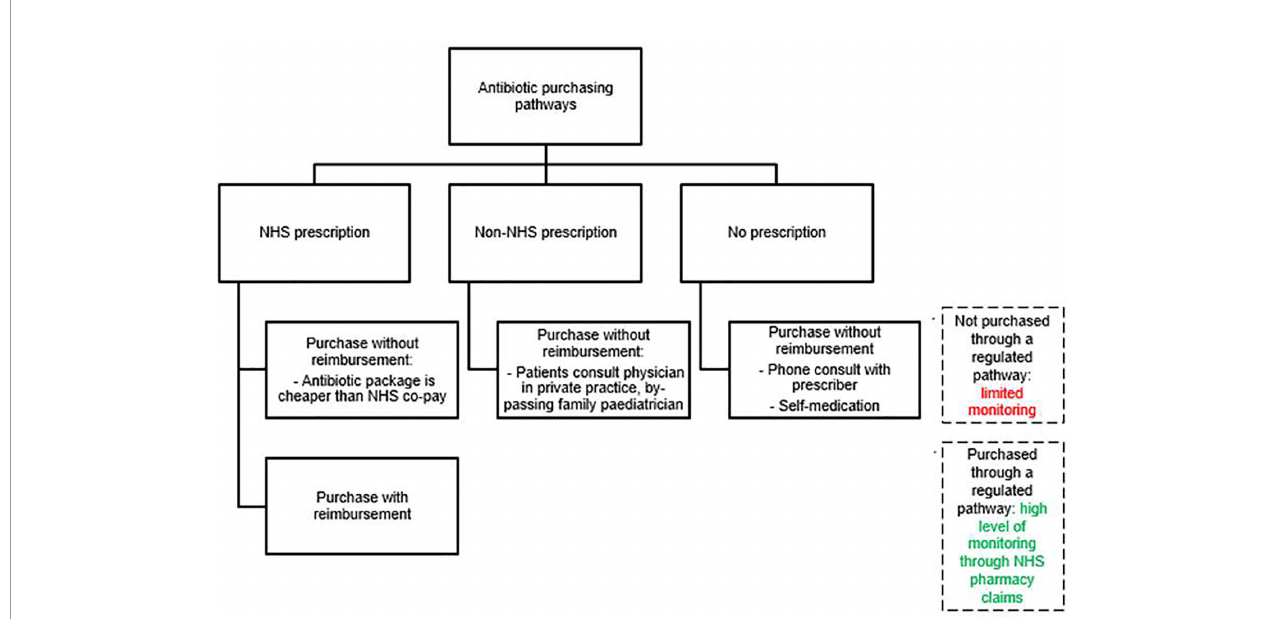
FIGURE 1 | Antibiotic purchasing pathways in Italy. NHS, National Healthcare